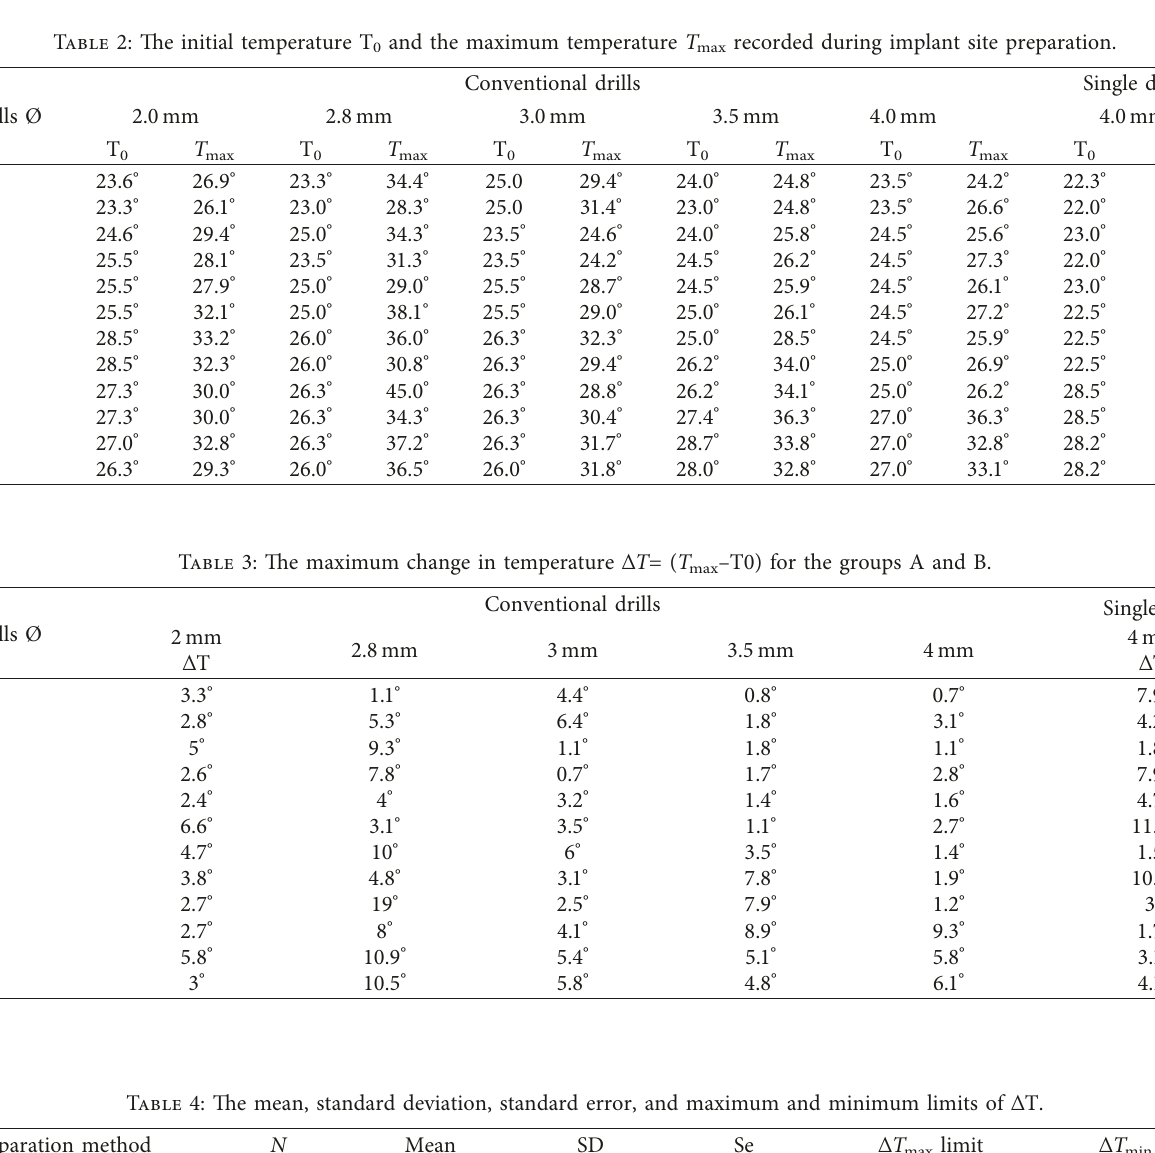
Table 2: The initial temperature T 0 and the maximum temperature T max recorded during implant site preparation.